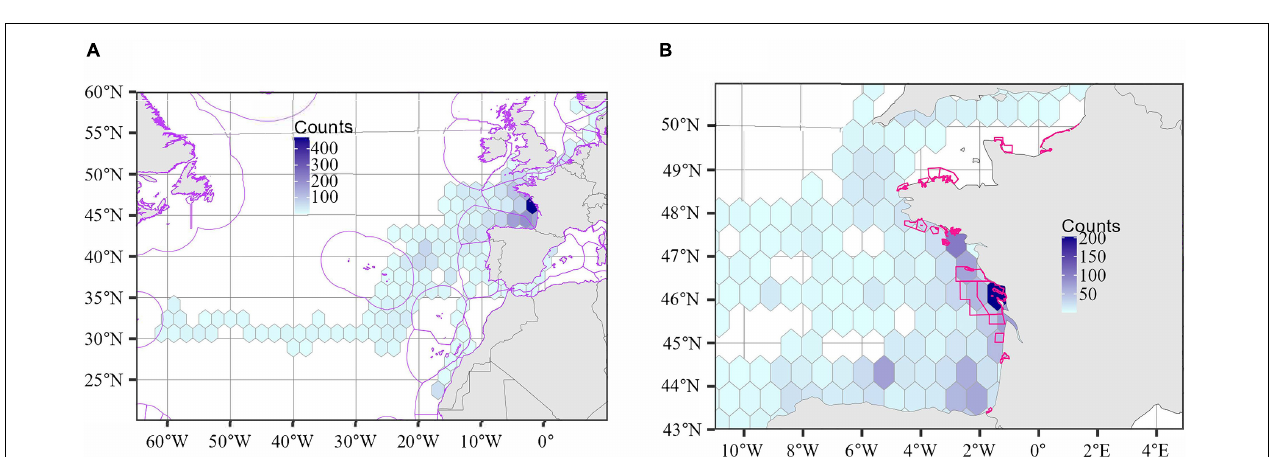
FIGURE 4 | Density plots of the 26 sea turtles (A) over the entire study region and (B) a focus over the French Atlantic coast and English Channel. The counts refer to the total number of locations recorded in each grid cell. The first week of tracking was removed to discard the potential effect of the release site and atypical behavior after release. Exclusive Economic Zones were overlaid (in purple, left) and Marine Protected Areas (in pink, right) in (A,B) , respectively.